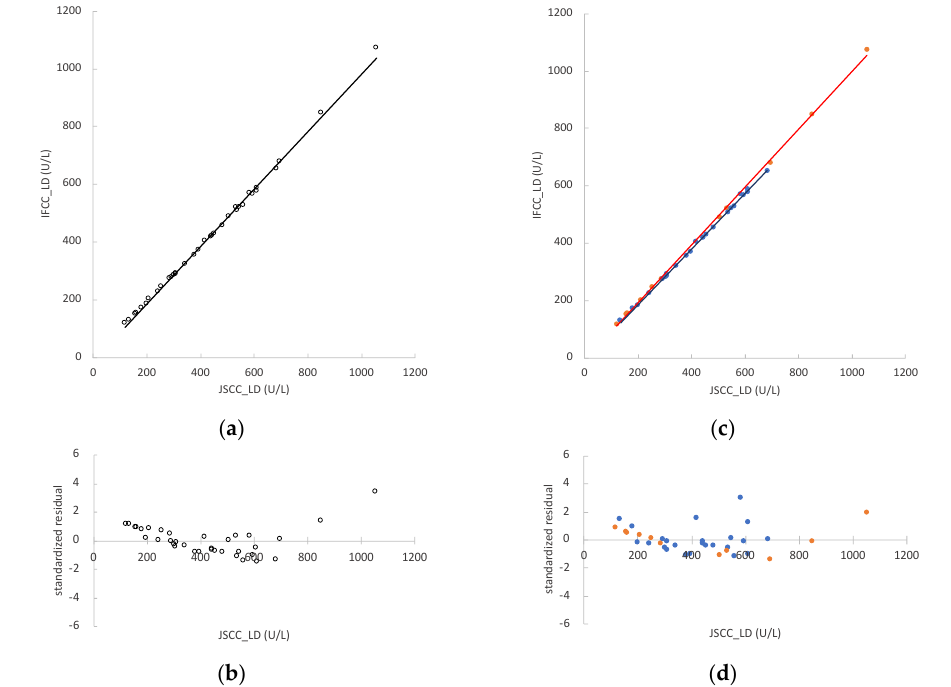
Figure 2. Correlation between lactate dehydrogenase (LD) activities measured by the Japan Society of Clinical Chemistry (JSCC) and International Federation of Clinical Chemistry and Laboratory Medicine (IFCC) methods in rat serum samples. The x-axes represent the values obtained by the JSCC method and the y-axes represent those obtained by the IFCC method: ( a ) regression analysis comparing the JSCC and IFCC values of all samples ( n = 35), represented by the formula y = 0.997x − 16.252; ( b ) standardized residual plots obtained using the regression equation of all samples ( n = 35); ( c ) regression analysis comparing the JSCC and IFCC values of non-hemolyzed samples ( n = 24, blue dots) and hemolyzed samples ( n = 11, orange dots), represented by the formulas y = 0.963x − 6.324 and y = 1.012x − 13.078, respectively; ( d ) standardized residual plots obtained using the re- gression equations of non-hemolyzed samples ( n = 24, blue dots) and hemolyzed samples ( n = 11, orange dots).